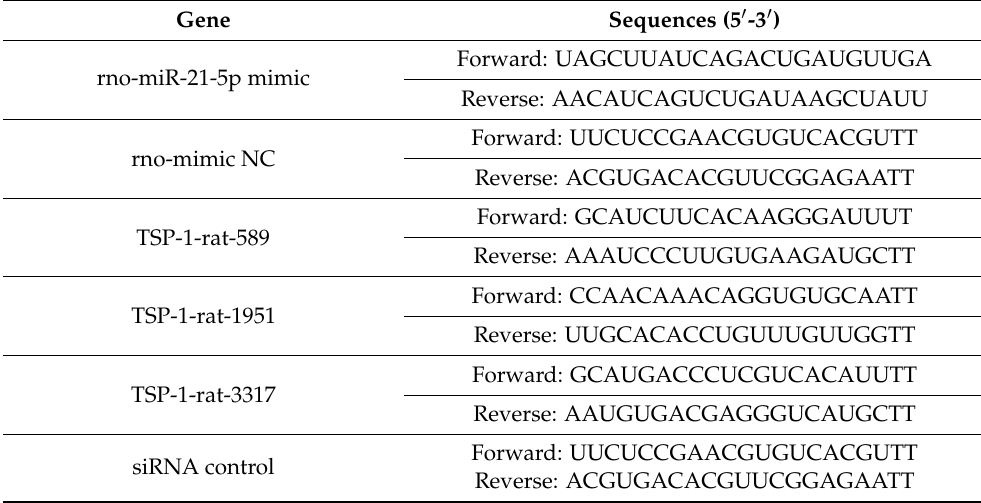
Table 2. Primers used for RNA